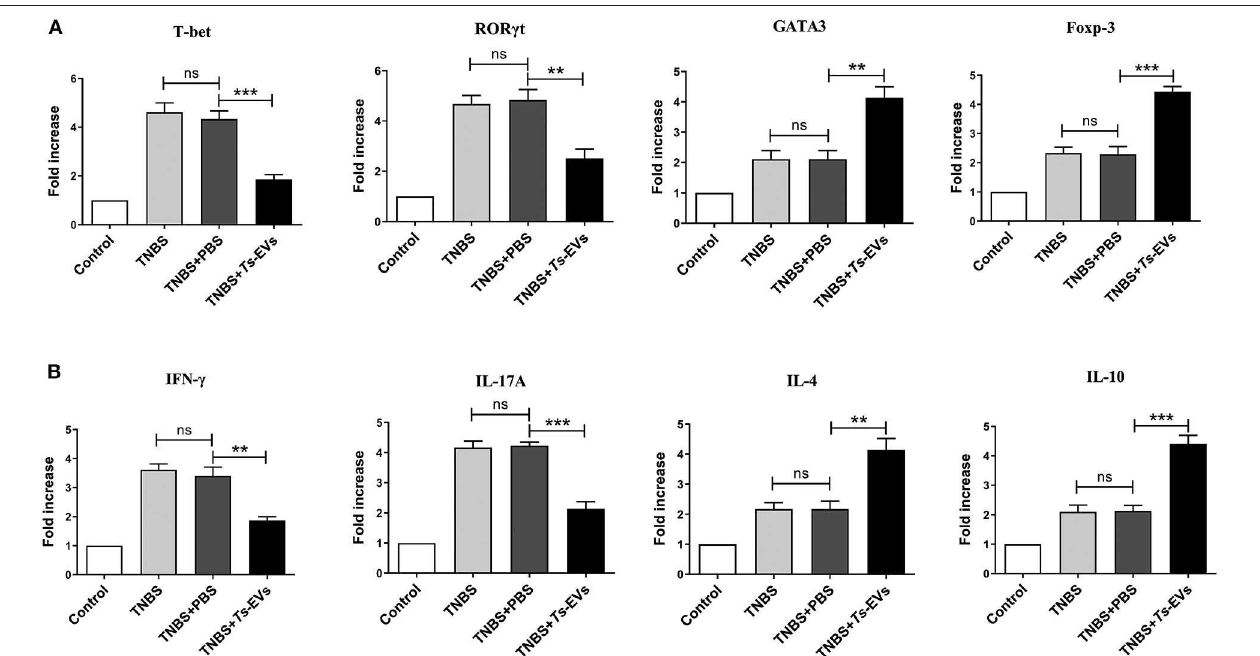
FIGURE 6 | qReal-time PCR analyses of gene expression levels in colons of mice with TNBS-induced colitis pretreated or not with Ts -EVs. (A) T-bet, GATA3, ROR γ t and Foxp-3 mRNA expression levels in the colons were measured by qRT-PCR. (B) IFN- γ , IL-17A, IL-4, and IL-10 mRNA expression levels. Results are shown as mean ± SD of each group ( n = 3). Statistical analysis was performed with one-way ANOVA followed by Tukey’s multiple-comparison test. ** p < 0.01, *** p < 0.001.